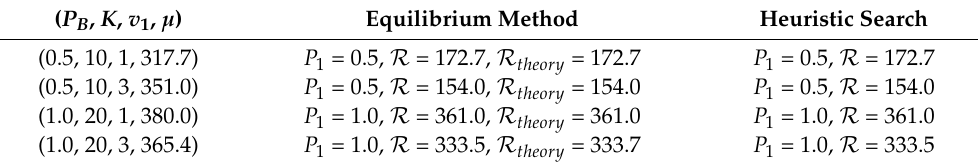
Table 8. Large capacity networks with frequent arrival rate broadcast ( F = 100).